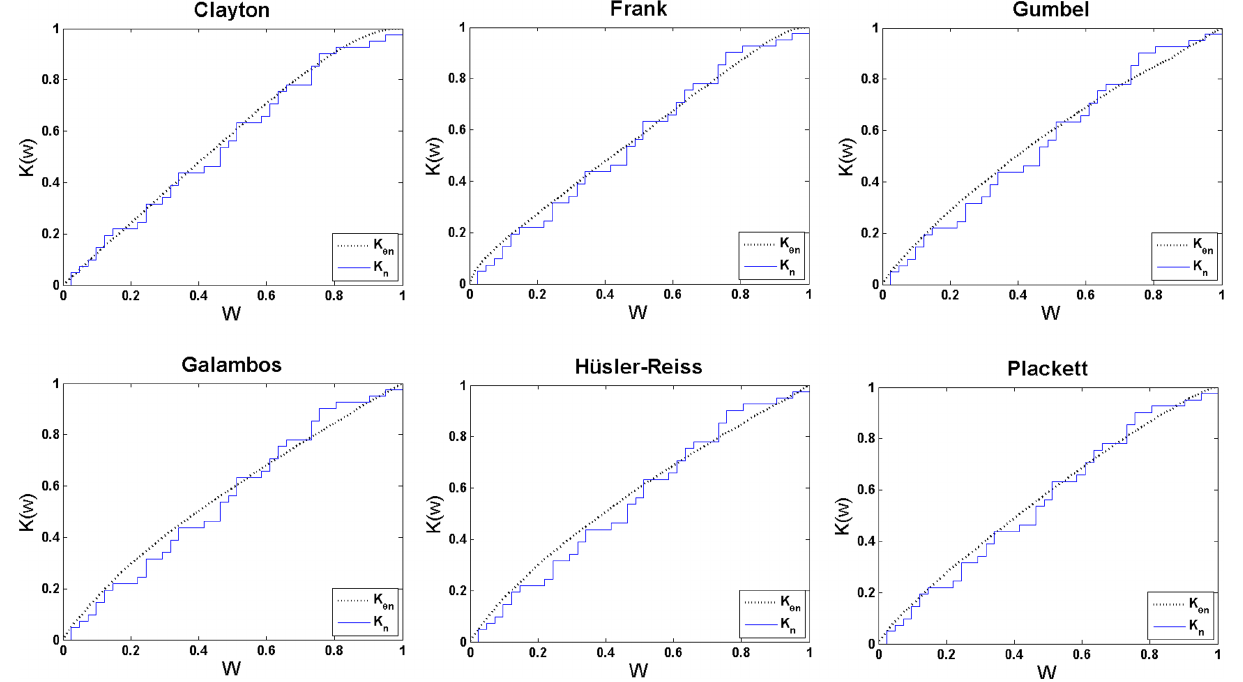
) and non-parametric ( K n ) estimate of K , considering the copulas fitted by the inversion of n